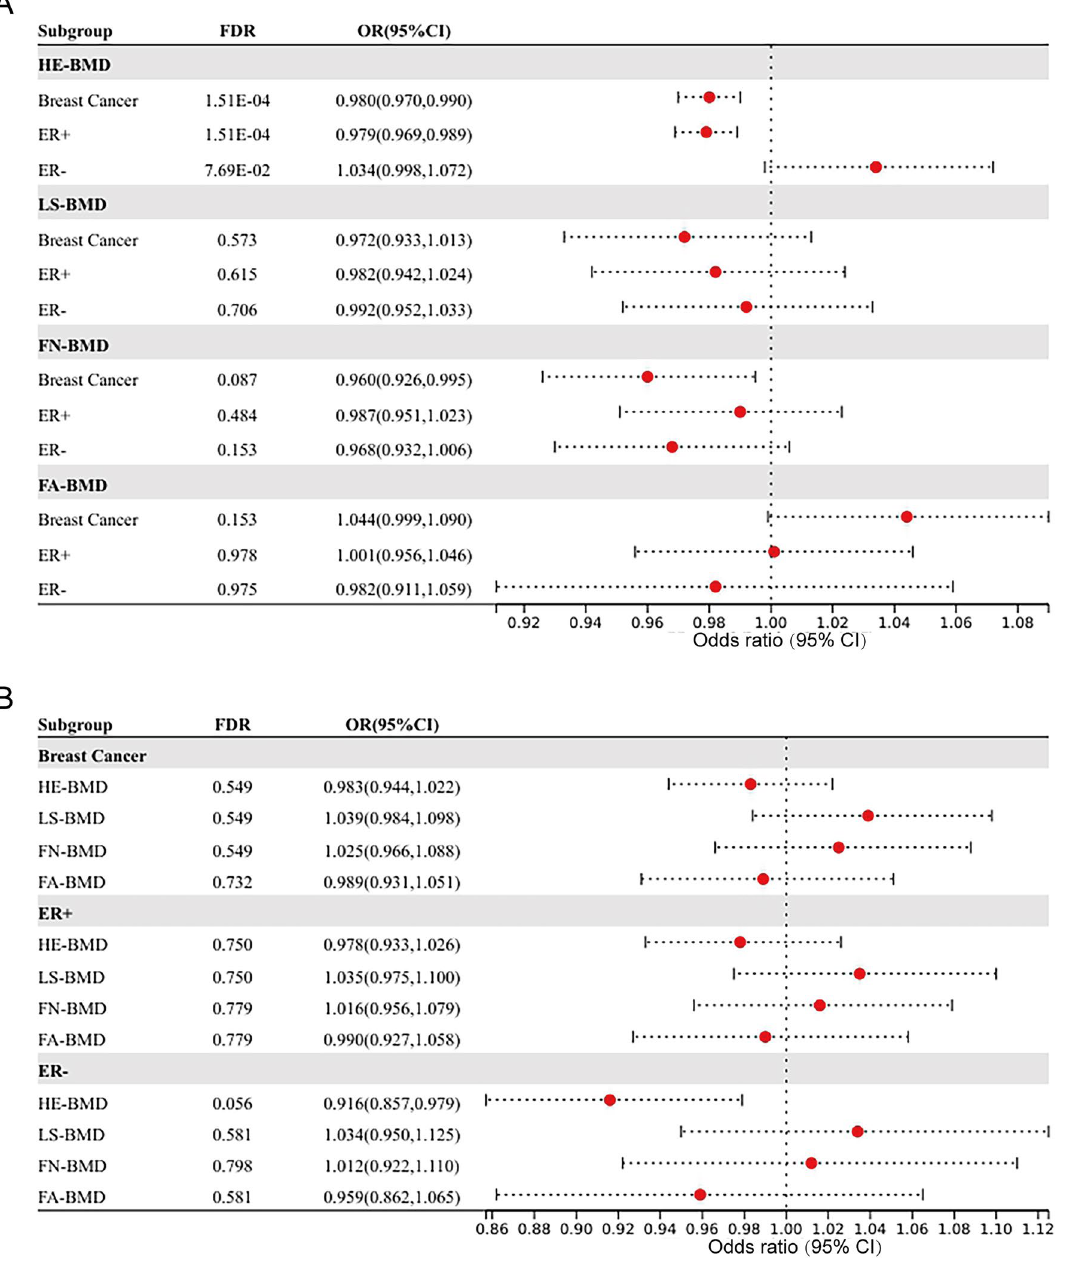
Figure 2. The forest plot of bidirectional Mendelian randomization results. ( A ) is the Mendelian randomization results of the association of breast cancer and its subtypes with bone mineral density at different sites. ( B ) is the Mendelian randomization results of the association of bone mineral density at different sites with breast cancer and its